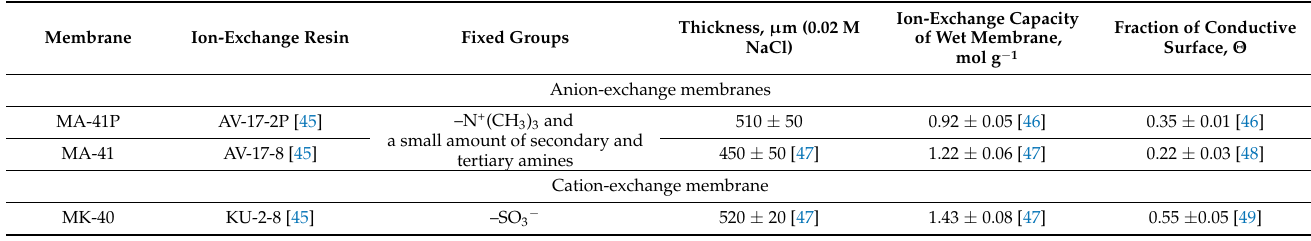
Table 1. Main characteristics of the